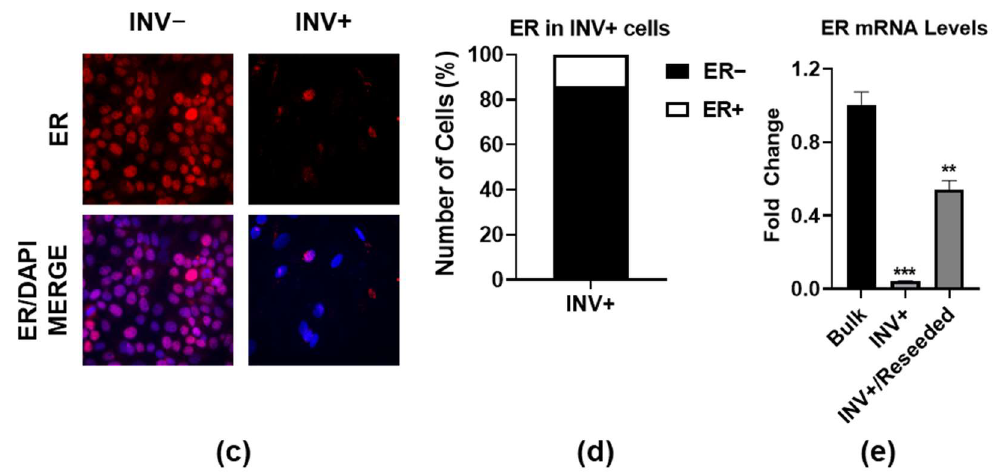
Figure 1. ER expression and activity in ER and IKKβ coactivated MCF-7 invasive vs. noninvasive cells. MCF-7-CA-IKKβ cells were treated with E2 (10 nM) +/− DOX (1 μg/mL) for 72 h, followed by +/− ICI 182,780 (ICI, 1 μM) for an additional 8 h. Equal numbers of cells were then seeded onto collagen-coated (10 μg/cm 2 ) transwell inserts and allowed to invade for 24 h. ( a ) Cells were fixed, stained with crystal violet, and counted using Image J. Fold change vs none was calculated. ( b ) Invaded (INV+) and noninvaded (INV − ) cells were collected from the bottom and top of the insert, respectively, and RNA was extracted. ER and ER target gene mRNA expression were assessed by QPCR. Fold change in INV+ relative to INV − is shown. ( c ) ER α protein expression (red) was assessed in INV− and INV+ cells by immunofluorescence. Cell nuclei were counterstained with DAPI (blue). ( d ) The percentage of INV+ cells expressing detectable levels of ER protein was quantified from immunofluorescent images. ( e ) ER mRNA levels were determined by QPCR in INV+ cells immediately after the invasion assay or after INV+ cells were returned to standard culture conditions for 72 hr with continuous E2 + DOX treatment. Expression was compared to the bulk population of E2 + DOX-treated cells, which had not been put through the invasion assay. ** p < 0.01; *** p < 0.001; ns: not significant.